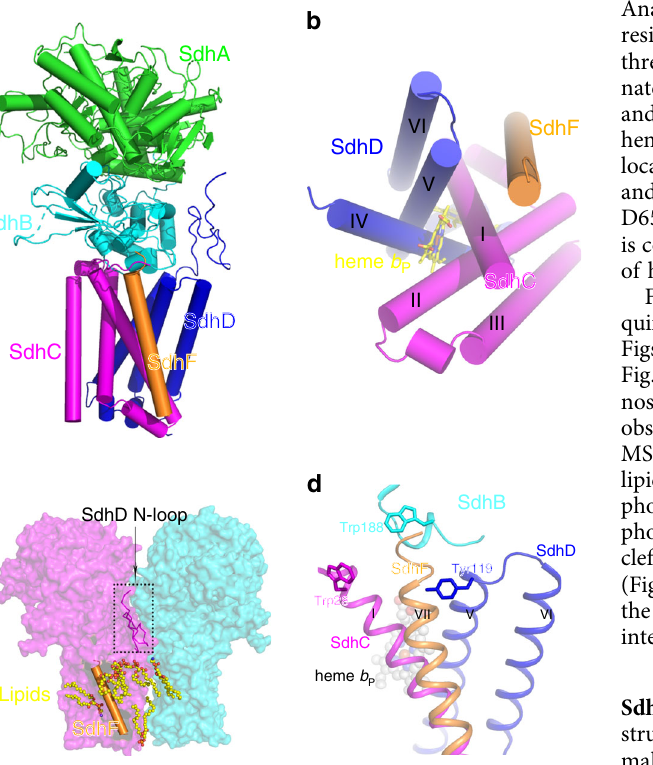
Fig. 2 Location and interaction of SdhF subunit in Sdh2 protein. a One copy of the complex is composed of fi ve subunits SdhA, SdhB, SdhC, SdhD, and SdhF, which are colored green, cyan, purple, blue, and orange, respectively. b Sequential display of transmembrane helices of the SdhC, SdhD, and SdhF subunits. c The distribution of phospholipids (shown in spheres) and SdhF subunit (shown in cylindric cartoon) and SdhD N-loop (shown in ribbons). d SdhF subunit is located in front of the conserved Q P -binding pocket. All the prosthetic groups (FAD, [2Fe-2S], [4Fe-4S], [3Fe-4S], and two b -type heme groups) were unambiguously assigned into the cryo-EM map (Supplementary Fig. 3b). It has been previously shown that different residues in the FAD-binding site are responsible for either ef fi cient SQR or QFR catalytic activity 32 .